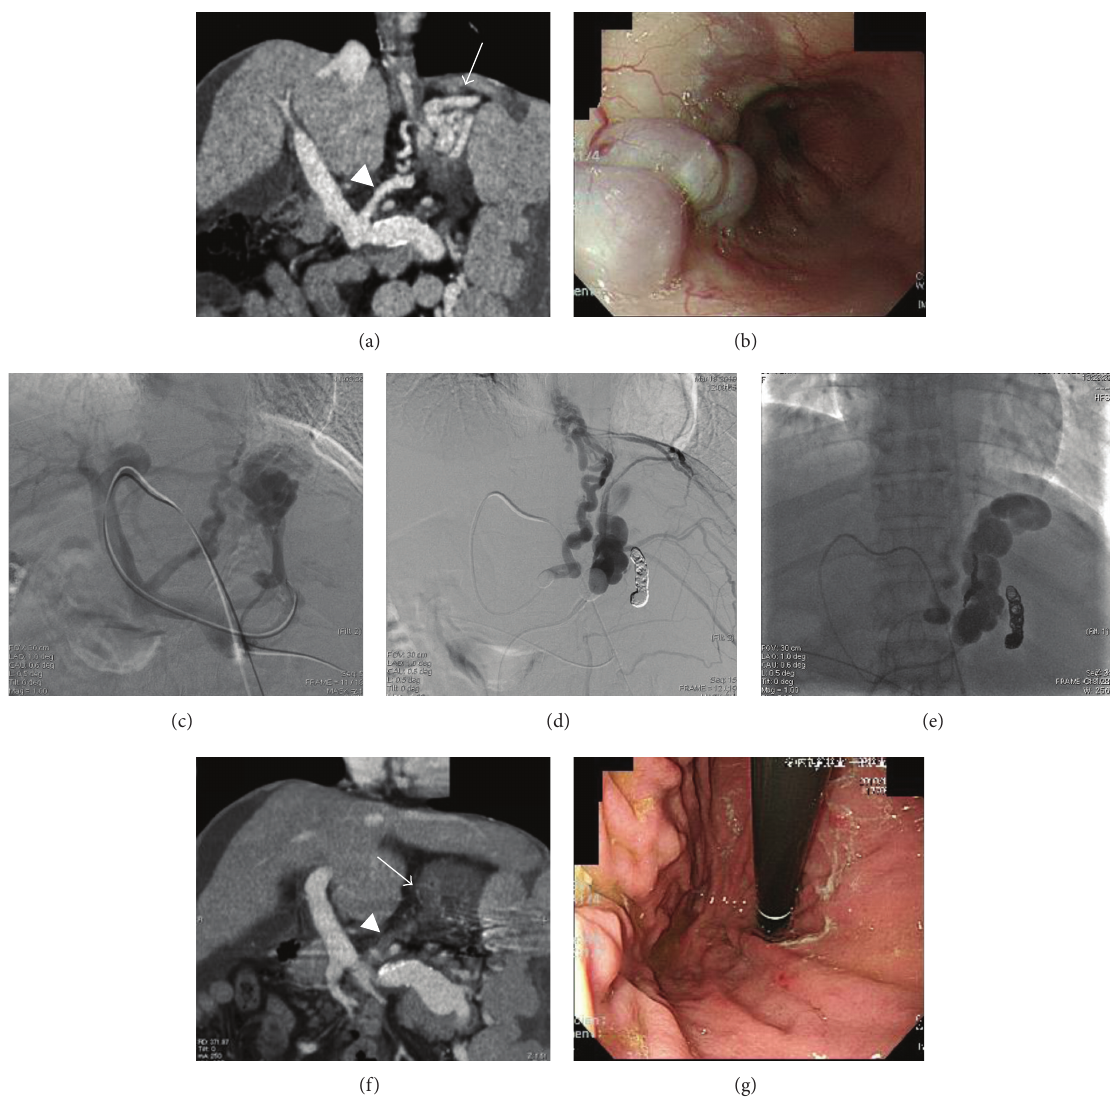
Figure 2: A 36-year-old woman with gastroesophageal varices. The patient visited our outpatient clinic because of general fatigue. Hematologic tests showed liver dysfunction and pancytopenia, and the gastroesophageal varices tended to worsen despite several sessions of endoscopic therapy. An enhanced computed tomography (CT) scan coronal image (a) showed dilated and tortuous veins at the gastric fundus (arrow), and large gastric varices supplied by the left gastric vein (arrowhead). Endoscopic examination of the stomach (b) showed significant large tumorous gastroesophageal varices (F3). Such varices pose a high risk of variceal bleeding and are an indication for embolotherapy. This patient underwent combined balloon-occluded retrograde transvenous obliteration (BRTO) and PTO therapy. Direct portography (c) showedgastroesophagealvaricesfromtheleftgastricveinandposteriorgastricvein.Balloon-occludedleftgastricvenographyandleftadrenal venography after embolization of the posterior gastric vein with platinum coils showed the left inferior phrenic vein and intercostal vein as collateral vessels (d). Fluoroscopic image obtained at 4 hours after embolotherapy shows the varices filled with iopamidol (e). An enhanced coronal CT scan obtained 14 days after embolotherapy showing the gastric varices and the left gastric vein as a low-density area ((f), arrow and arrowhead), suggesting complete obliteration. Endoscopic examination conducted 6 months after the embolotherapy showed eradication of the gastroesophageal varices